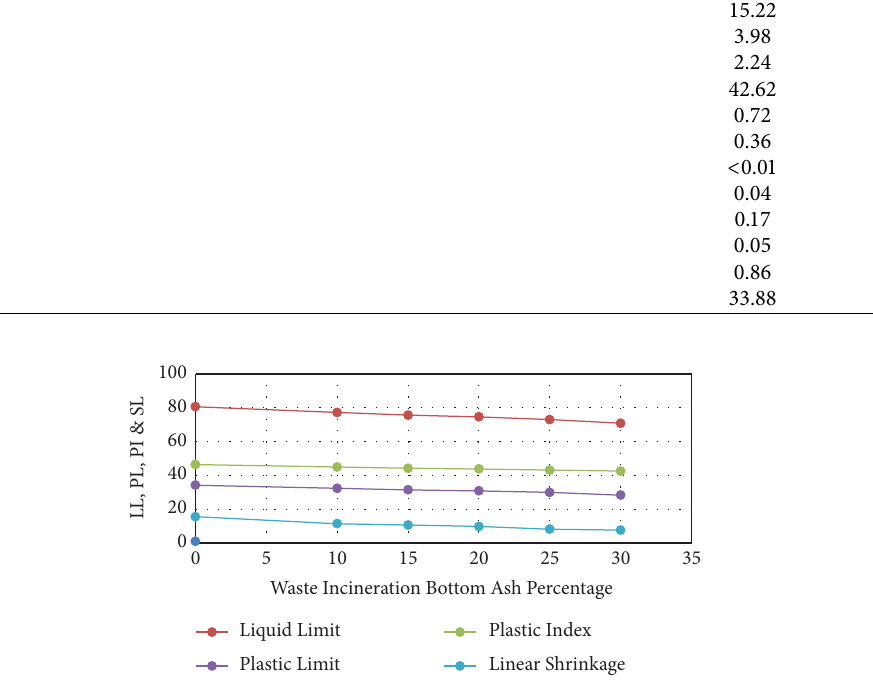
Figure 1: Efect of waste incineration bottom ash liquid limit, plastic limit, plastic index, and linear shrinkage.